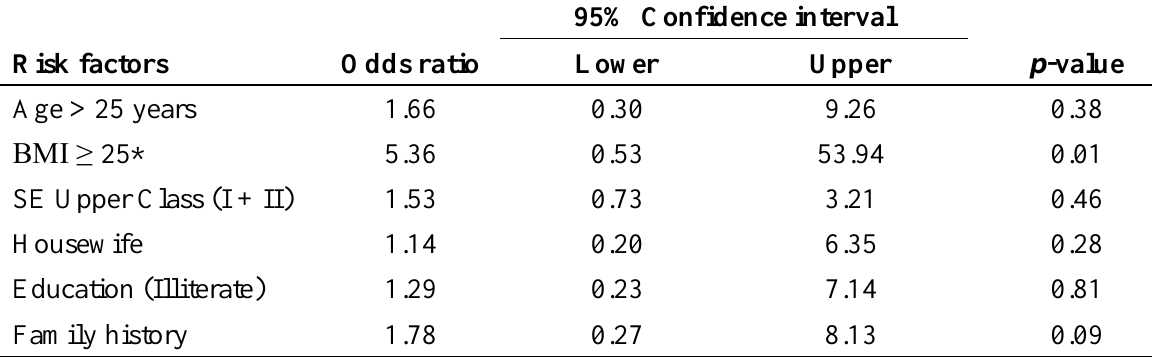
Table 4: Odds ratio for risk factors found to be associated with gestational